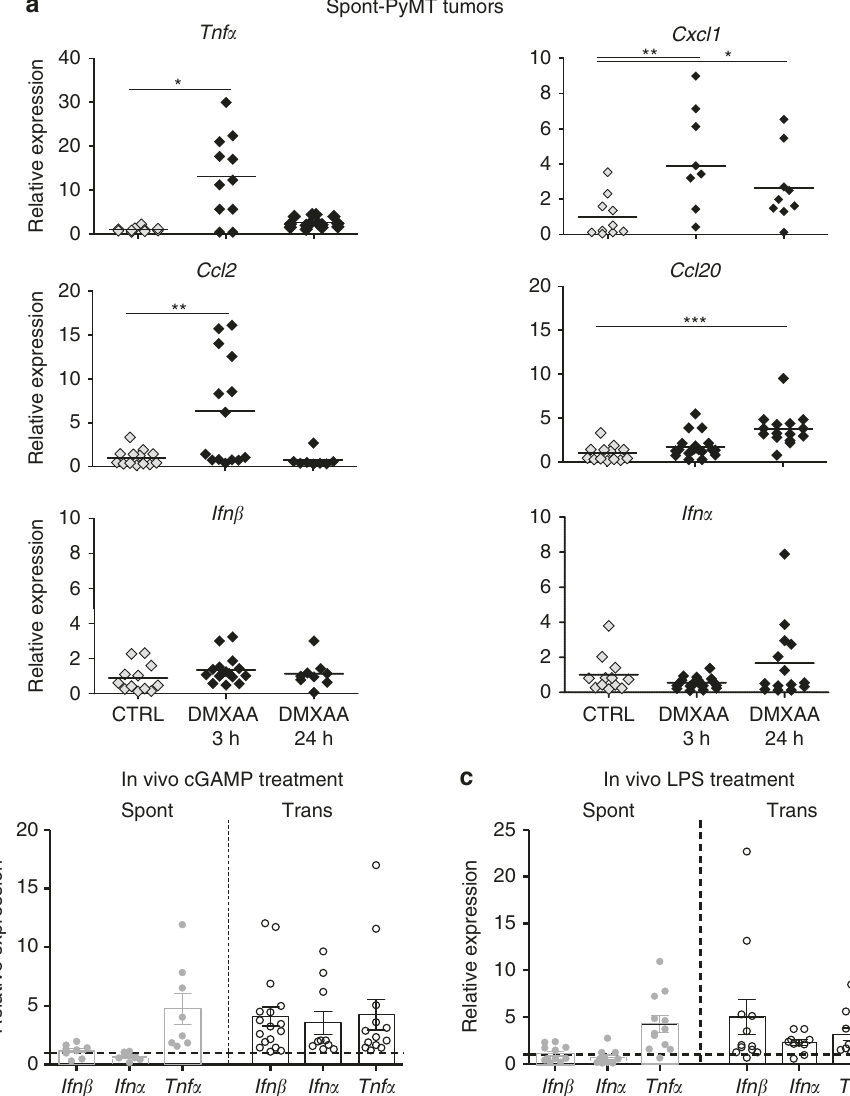
Fig. 3 Lack of type I IFN triggering in Spont-PyMT tumors. a Spont-PyMT mice were injected i.p. with DMXAA and then killed after 3 h or 24 h to measure mRNA levels of cytokines and chemokines in tumors. The relative expressions in DMXAA-treated (black diamonds), compared with DMSO-treated (gray diamonds), mice are shown. Each dot corresponds to one tumor. Cumulative data from CTRL: n = 6 mice and DMXAA: n = 6 mice, from three independent experiments, are shown. Tukey ’ s multiple comparison test. * p < 0.05; ** p < 0.01; *** p < 0.001. b , c The relative expression of these cytokines/chemokines, compared with PBS (CTRL) injected mice, were measured in Spont-PyMT (gray circles) and Trans-PyMT (open circles) target lesions 3 h after ( b ) cGAMP (25 μ g i.t.) injection (Spont-PyMT mice: n = 3 CTRL and n = 3 cGAMP; Trans-PyMT mice: n = 5 CTRL and n = 13 cGAMP) or ( c ) LPS (50 μ g i.p.) injection (Spont-PyMT mice: n = 3 CTRL and n = 3 LPS; Trans-PyMT mice: n = 5 CTRL and n = 10 LPS) from three independent experiments. In b and c , the results are expressed as mean ± SEM. Source data are provided as a Source Data fi